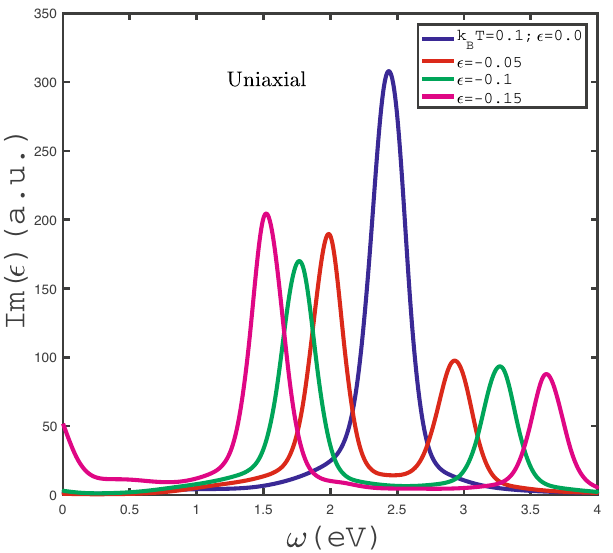
Figure 7. Optical absorption, Im (ǫ) , of undoped MoS 2 layer as a function of photon frequency in the presence of negative uniaxial strain for different strain parameter, namely ε magnetic field at fixed temperature k B T